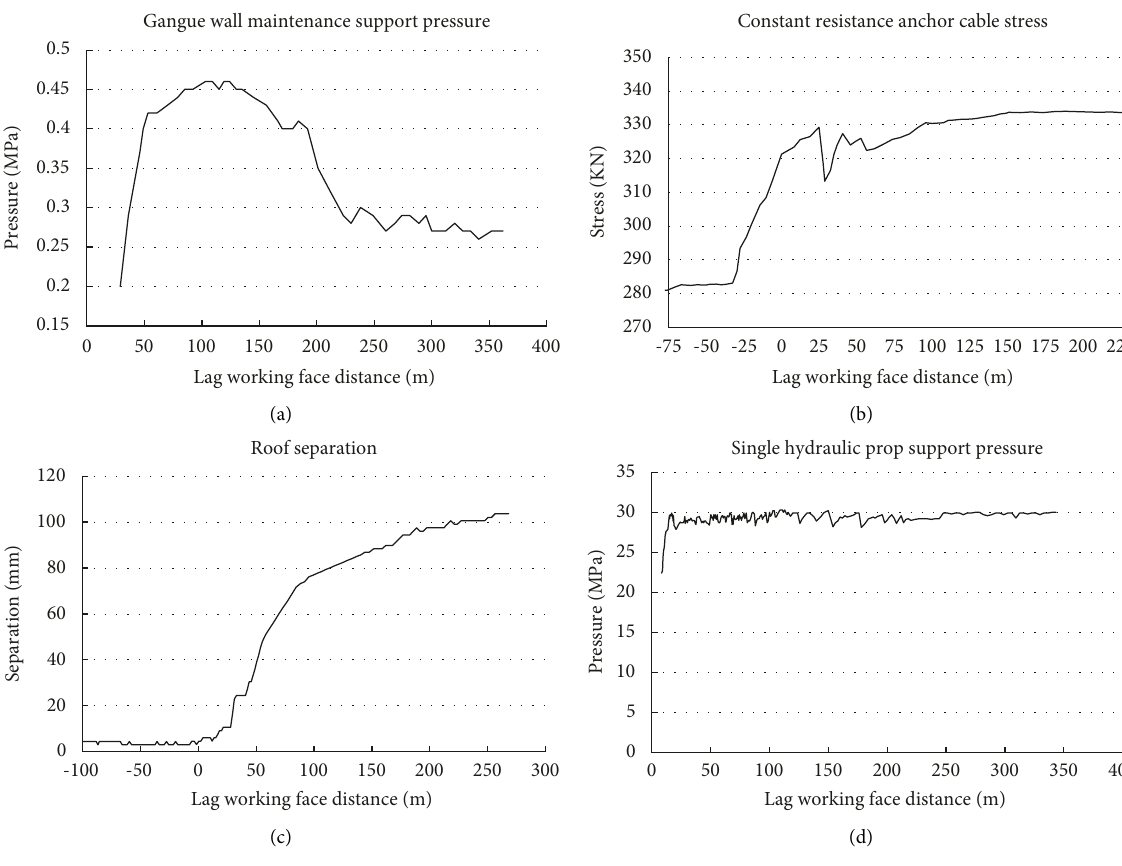
Figure 15: Monitoring results. (a) Gangue wall maintenance support pressure. (b) Constant resistance anchor cable stress. (c) Roof separation. (d) Single hydraulic prop support